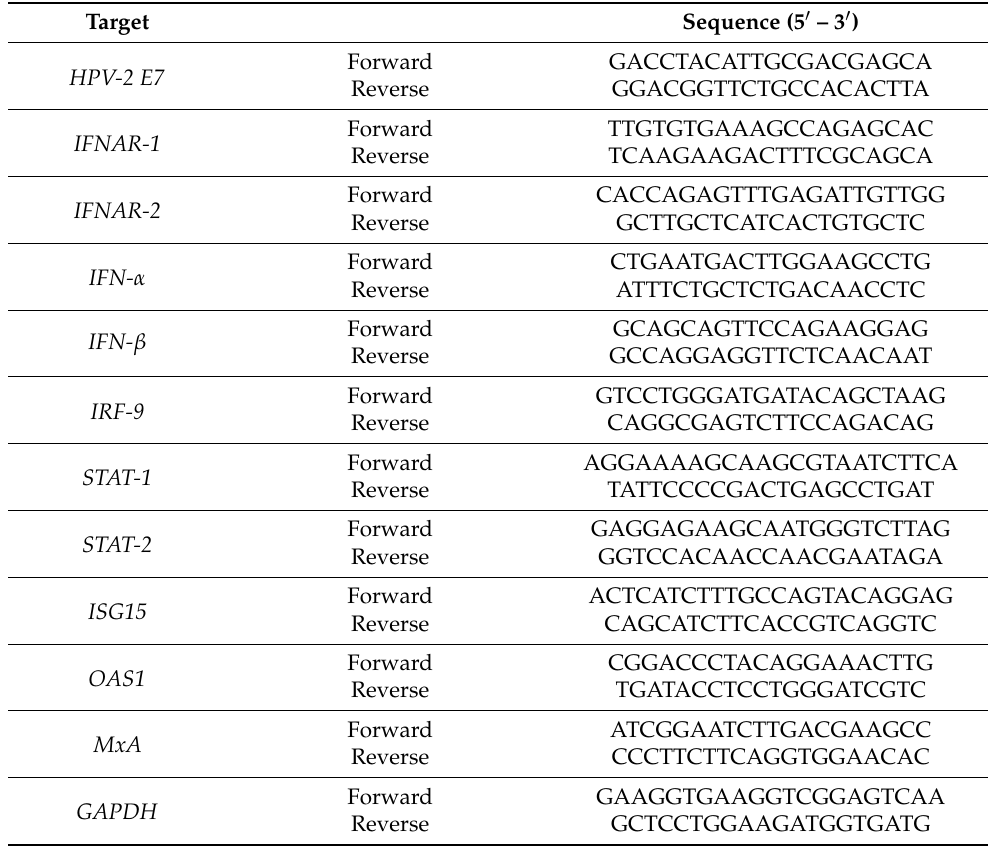
Table 1. Primers sequences for RT-qPCR